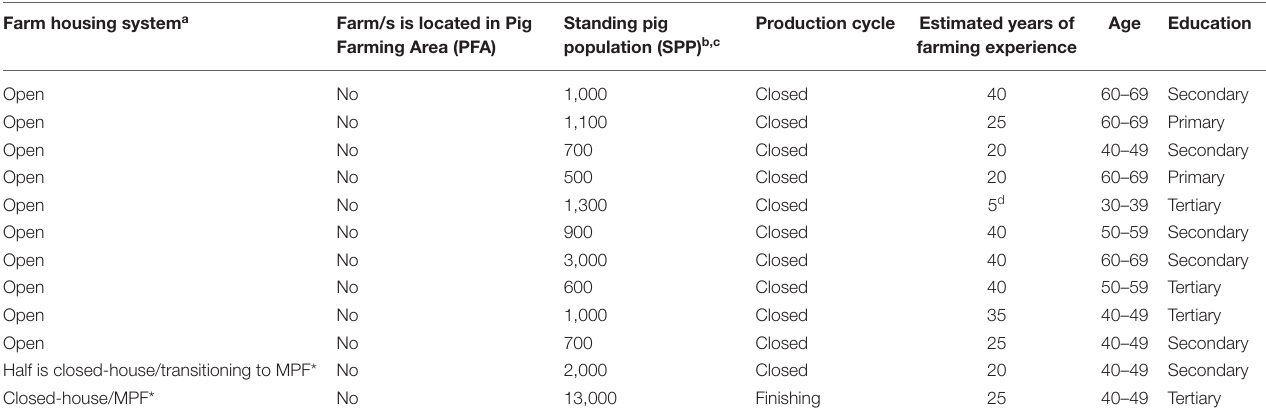
FIGURE 2 | Simplified conceptual map of 12 male Malaysian pig farmers’ (10 small-medium-scale farms, 2-large scale farms) mental model in implementing disease prevention and control practices during the 1998 Nipah outbreak and in 2019. The dimensions of the mental model were categorized into internal dimensions: (1) drivers of action to prevent and control disease, (2) perception of practice options which is an evaluation on options of disease prevention and control practices, (3) individual determinants which are individual factors affecting disease control and prevention choices; and external dimensions: (4) external social factors, (5) external economic factors, and (6) additional external factors. TABLE 1 | Characteristics of farms and farmers who participated in the